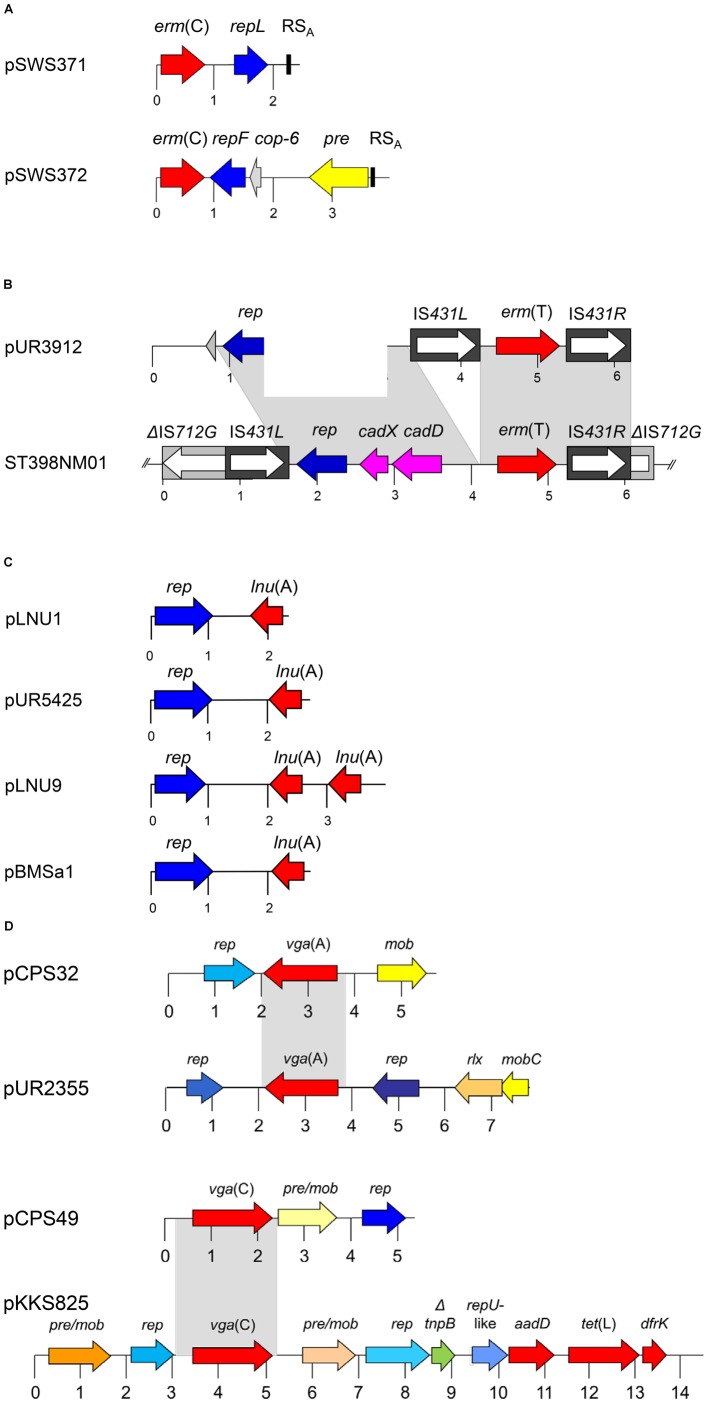
Schematic presentation of the organization of (A) the two erm (C)-carrying plasmids pSWS371 and pSWS372, (B) the erm(T)-carrying plasmid pUR3912 and the chromosomal erm(T) region of MRSA ST398 isolate ST398NM01, (C) the lnu(A)-carrying plasmids pLNU1, pLNU9, pUR5425, and pBMSa1, and (D) the vga(A)- and the vga(C)-carrying plasmids pCPS32, pUR2355, pCPS49 and pKKS825 from MRSA ST398. The reading frames are presented as arrows with the arrowhead indicating the direction of transcription. A distance scale in kb is given below the maps. The resistance genes are indicated in red, plasmid replication genes rep in different shades of blue, and genes involved in plasmid recombination, mobilization and relaxation pre, mob, pre/mob, and rlx in different shades of yellow/-orange. The different blue and yellow-orange shadings indicate differences in the respective genes. In panel (A), the plasmid copy control gene cop-6 is displayed in gray and the staphylococcal recombination site A (RSA) is indicated by a black box. In panel (B), the cadmium resistance operon cadDX is shown in pink and the IS431 elements and the IS712G element are displayed as black or gray boxes, respectively, with the white arrow inside representing the transposase gene tnp. The gray-shaded areas represent areas of at least > 95% sequence identity. This figure is modified from Lüthje et al. (2007) and Kadlec et al. (2010), Gómez-Sanz et al. (2013a), and Wendlandt et al. (2014b).